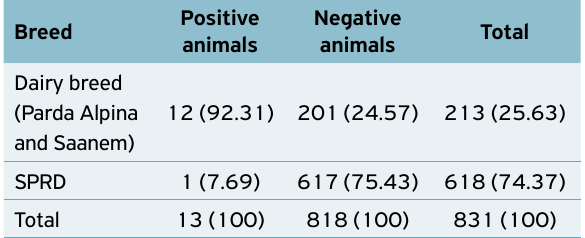
Table 3. Statistical analysis of the serological results for goat lentivirus on dairy breeds (Parda Alpina and Saanen) and without defined racial pattern (SPRD), from the sisal territory, Bahia, Brazil.